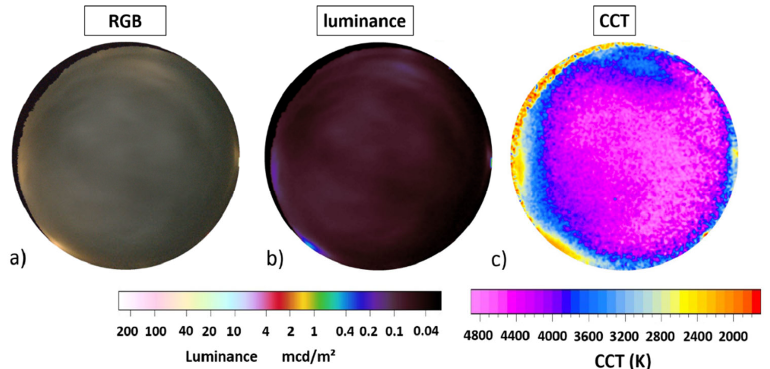
Figure 7. Imaging data taken during an overcast night on a beach near the village of Saunags, Latvia: ( a ) full-color RGB image, ( b ) luminance map and ( c ) CCT map. With a zenith brightness of 22.9 mag/arcsec² and a horizontal illuminance of 0.22 mlx, this measurement represents the darkest site the authors have surveyed with this method so far.